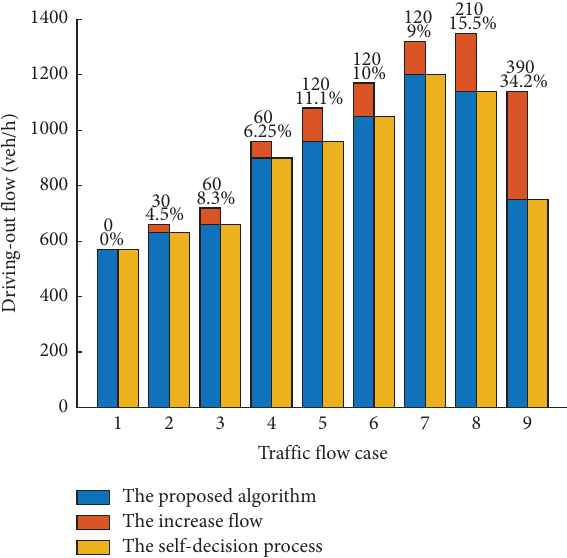
Figure 15: Comparative results with various trafc